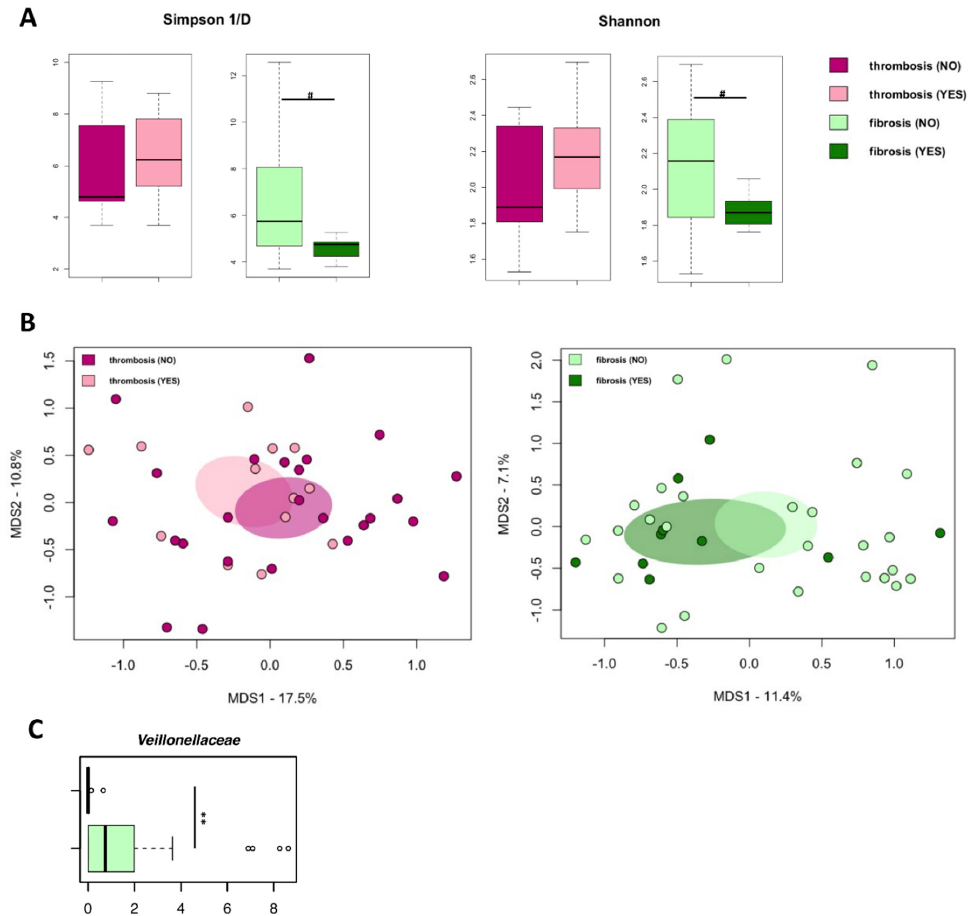
Figure 5. The gut microbiome of PV patients. ( A ) Alpha diversity estimated according to inverse Simpson (top) and Shan- non (bottom) indices of PV patients with or without thrombosis history and marrow fibrosis. ( B ) Principal coordinates analysis (PCoA) based on Jaccard similarity between the genus-level microbiota profiles of PV patients with or without thrombosis history and marrow fibrosis. ( C ) Boxplot showing the relative abundance distribution of the genera that were